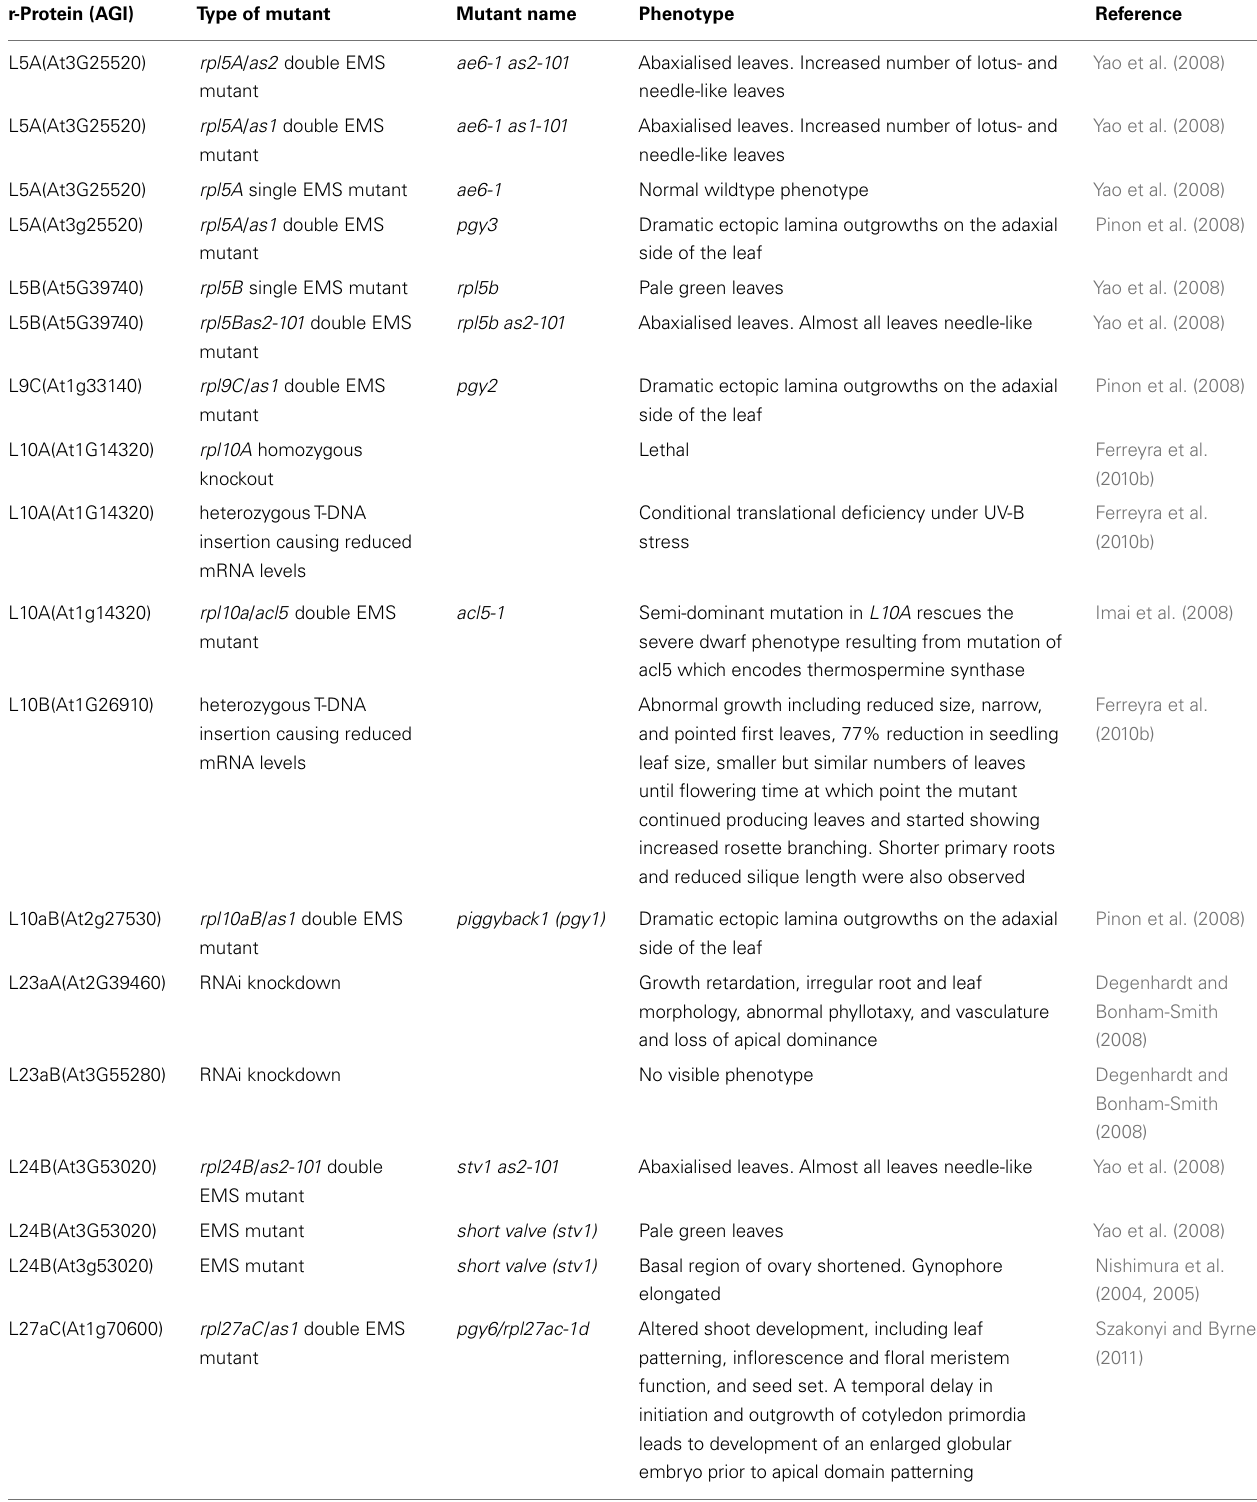
Table 3 | Published A. thaliana r-protein mutants and their